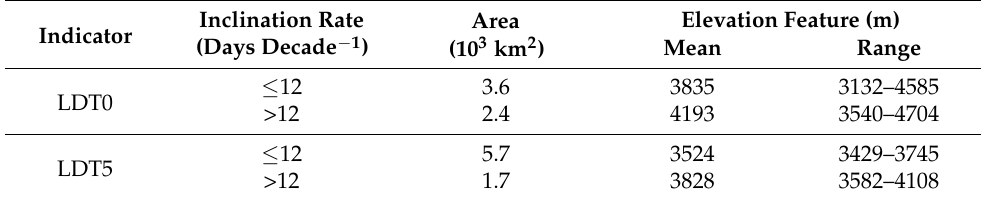
Figure 5. The inclination rate of lasting days with mean daily temperature ≥ 0 °C ( a ) and ≥ 5 °C ( b ) where the determination coefficient R 2 of regression analysis ≥ 0.5 during 1979–2018 in the source region of the Yellow River. Table 6. The area and elevation features of the inclination rates of the LDT with the determination coefficient R 2 of regression analysis ≥ 0.5.